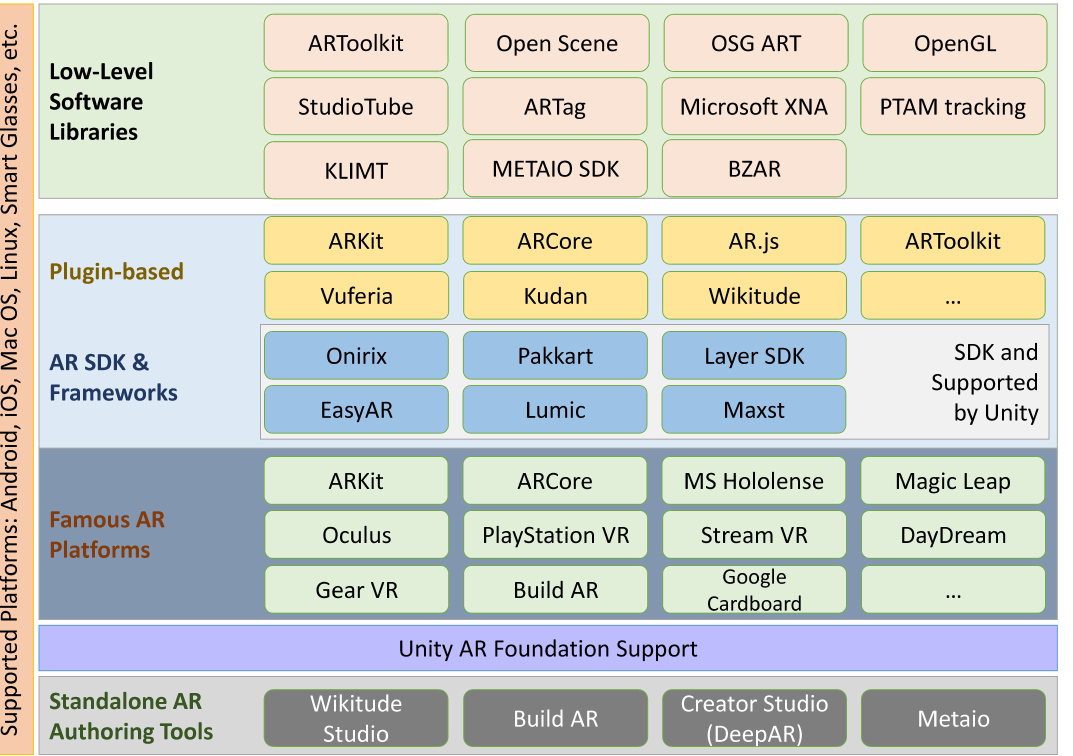
Figure 9. Stack of development libraries, plug-ins, platforms, and standalone authoring tools for augmented reality